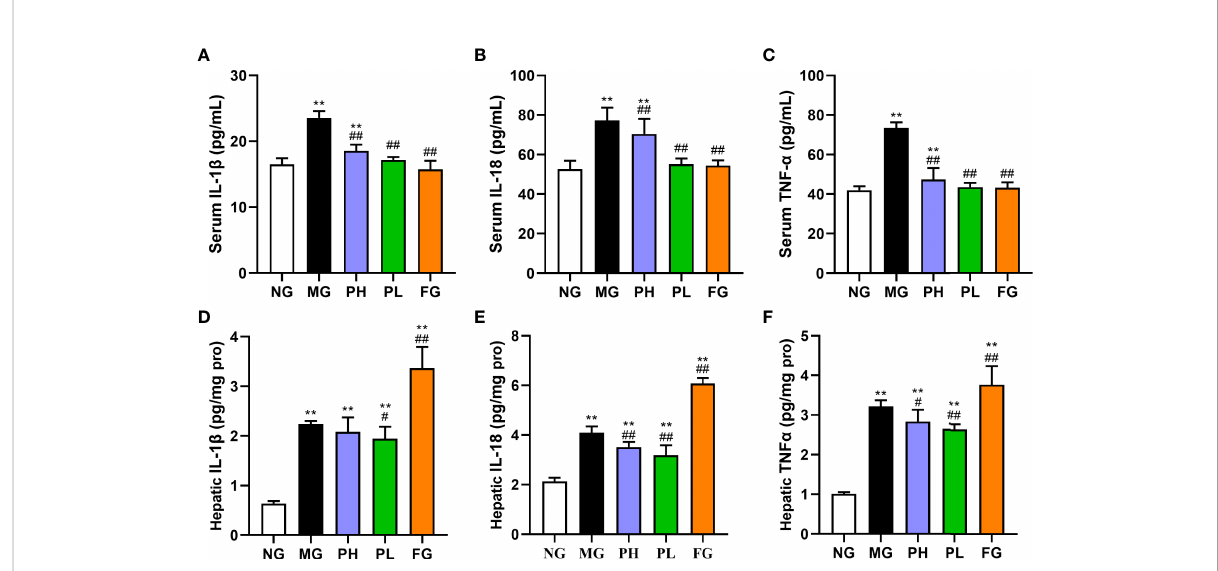
FIGURE 5 Effect of puerarin on in fl ammatory cytokines. (A) Serum IL-1 b ; (B) serum IL-18; (C) serum TNF- a ; (D) hepatic IL-1 b ; (E) serum IL-18; (F) hepatic TNF- a . Data were expressed as mean ± SD (n = 10). *p < 0.05, **p < 0.01, vs. NG; ##p < 0.01, vs.